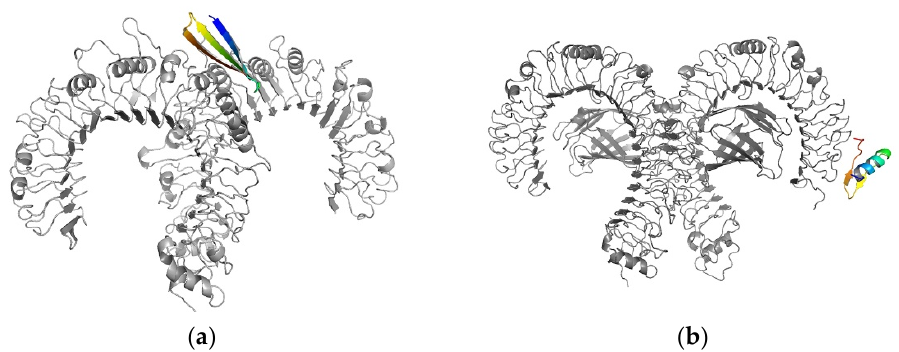
Figure 4. ( a ) One synthetic long peptide (colored)-toll-like receptor 2 (gray) docked complex with a binding energy of −12.5 kcal/mol ( b ) Toll-like receptor 4 (gray) in complex with a synthetic long peptide (colored) presenting a binding energy of −10.8 kcal/ mol.